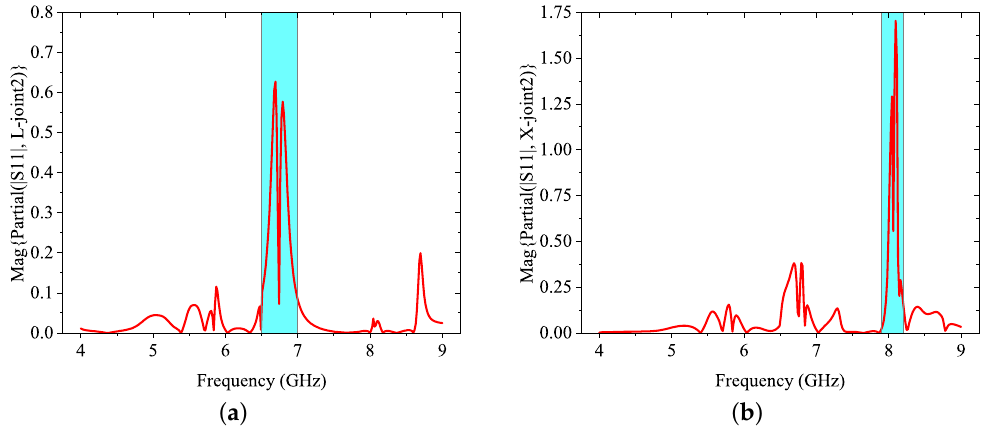
Figure 8. Parameter sensitivity of X joint 2 and L joint 2 . ( a ) Magnitude of the partial derivative of S 11 over L joint 2 ; and ( b ) Magnitude of the partial derivative of S 11 over X joint 2